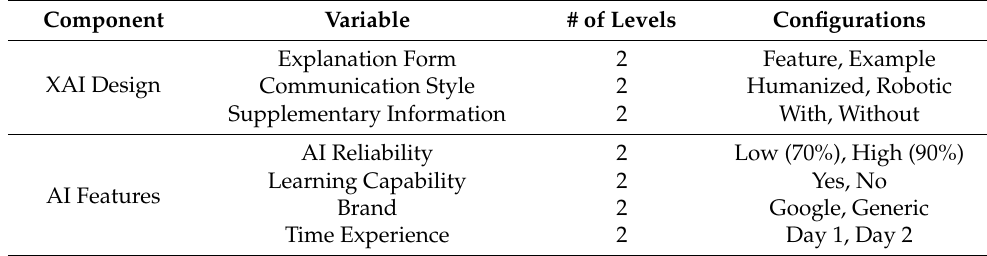
Table 1. Experimental design